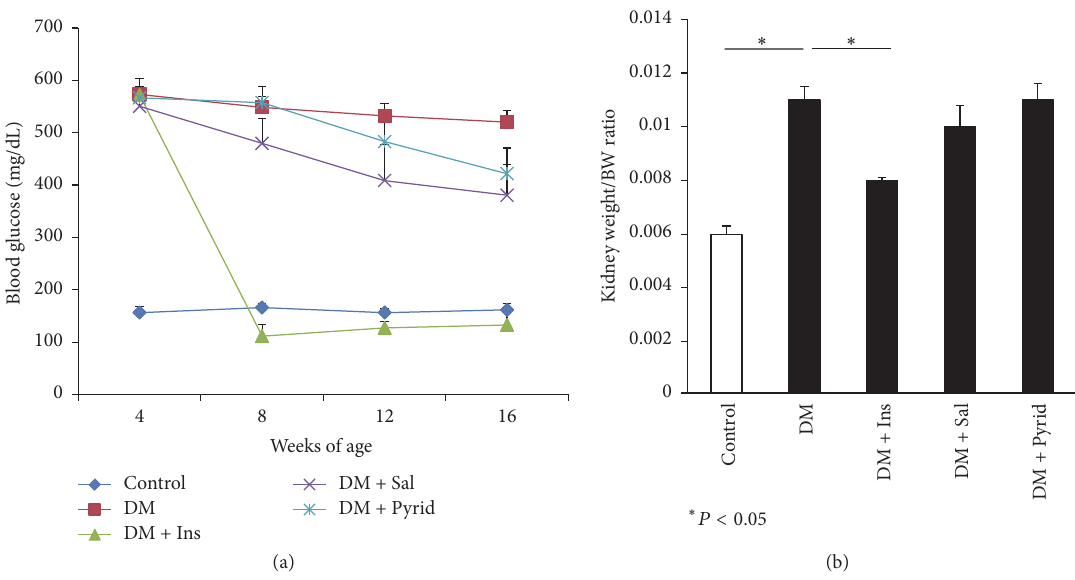
Figure 1: Blood glucose levels and nephromegaly. Nonfasting blood glucose levels in nondiabetic control (Control), diabetic mice without treatment (DM), diabetic mice with insulin treatment (subcutaneous injection of Levemir 2 units/kg body weight twice a day) (DM + Ins), diabetic mice with salicylate treatment (sodium salicylate 3 g/kg in the diets) (DM + Sal), and diabetic mice with pyridoxamine treatment (pyridoxamine dihydrochloride 1g/L in the drinking water) (DM + Pyrid) (a). Kidney weight per body weight ratio (g/g) (b). Control ( 𝑛 = 8 ), DM ( 𝑛 = 19 ), DM + Ins ( 𝑛 = 8 ), DM + Sal ( 𝑛 = 12 ), and DM + Pyrid ( 𝑛 = 15 ). Values are mean ± SEM. Table 2: Diabetic parameters in 16-week-old diabetic mice with or without treatment. Control DM DM + Ins DM + Sal DM + Pyrid 57.7 ± 1.5